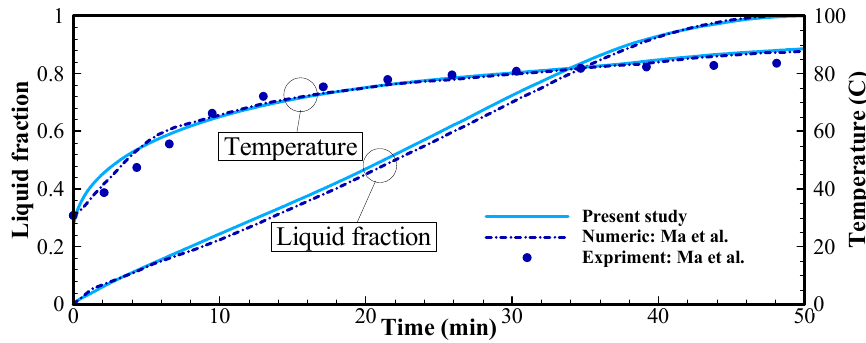
Figure 4. Verification of the current study compared with the practical data of Mat et al. [31] .